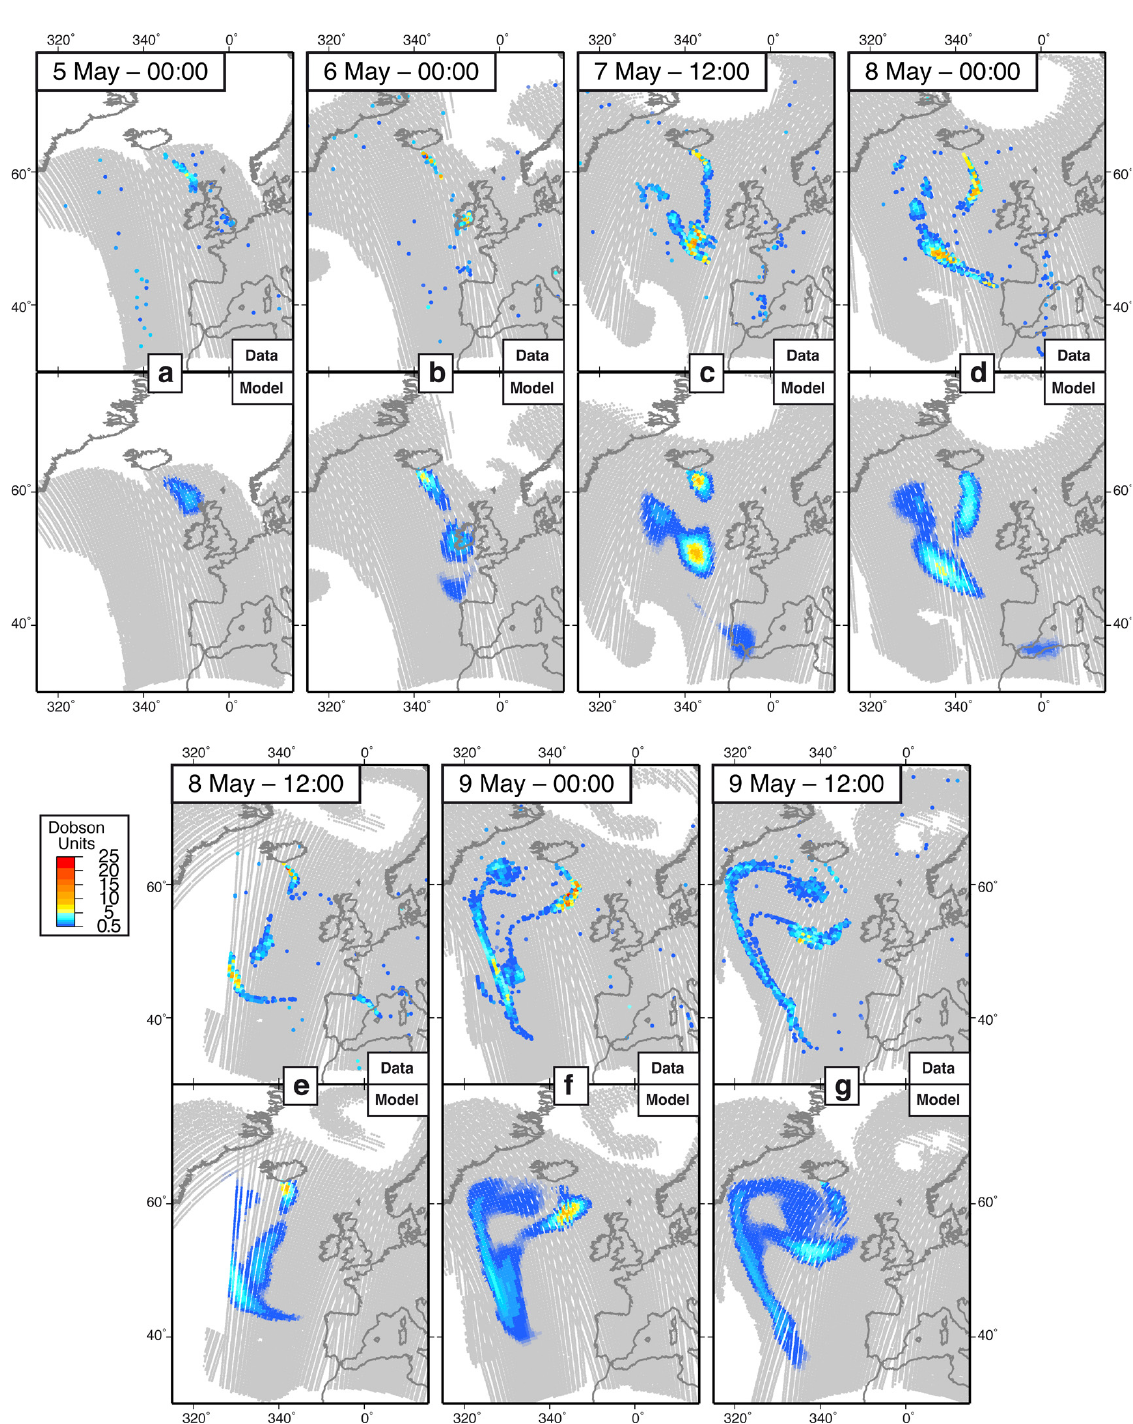
Fig. A1. Complete time series of observed and modelled maps, numbered a to m in Fig. 5, which illustrates the atmospheric evolution of the Eyjafjallaj¨okull plume from 1 to 12 May 2010. The reader is referred to the legend of Fig. 5 for